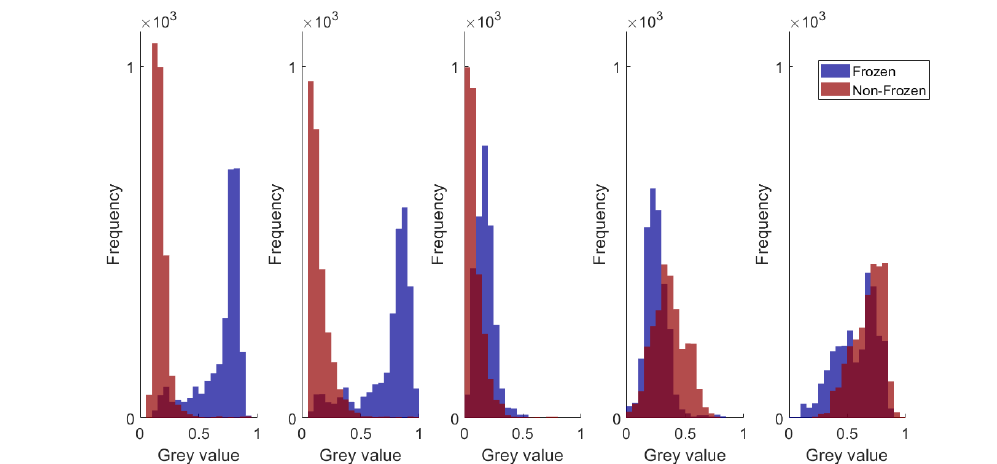
Figure 11. VIIRS grey-value histograms for sanity check (Bands I 1 , I 2 , I 3 , I 4 , I 5 are respectively shown from left to